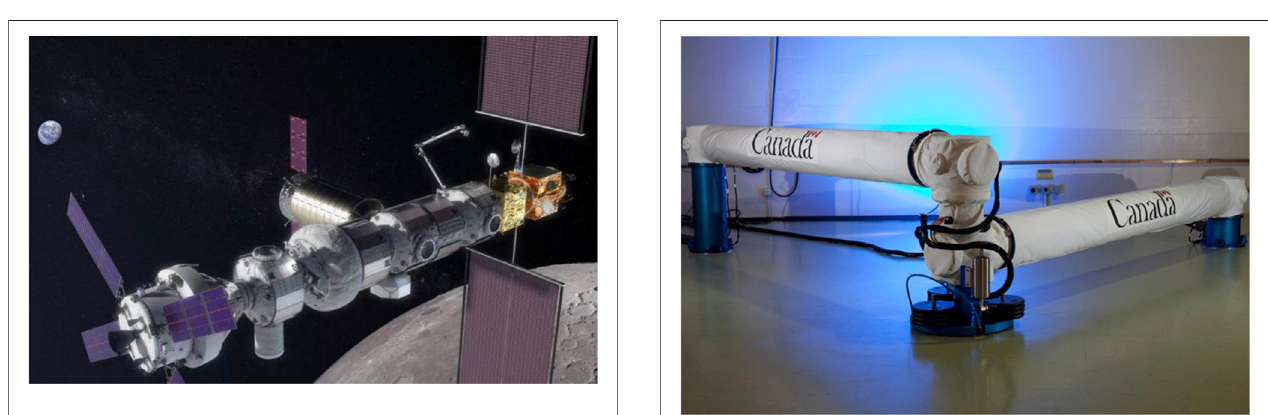
FIGURE 14 | The gateway extravehicular robotic system (GERS).